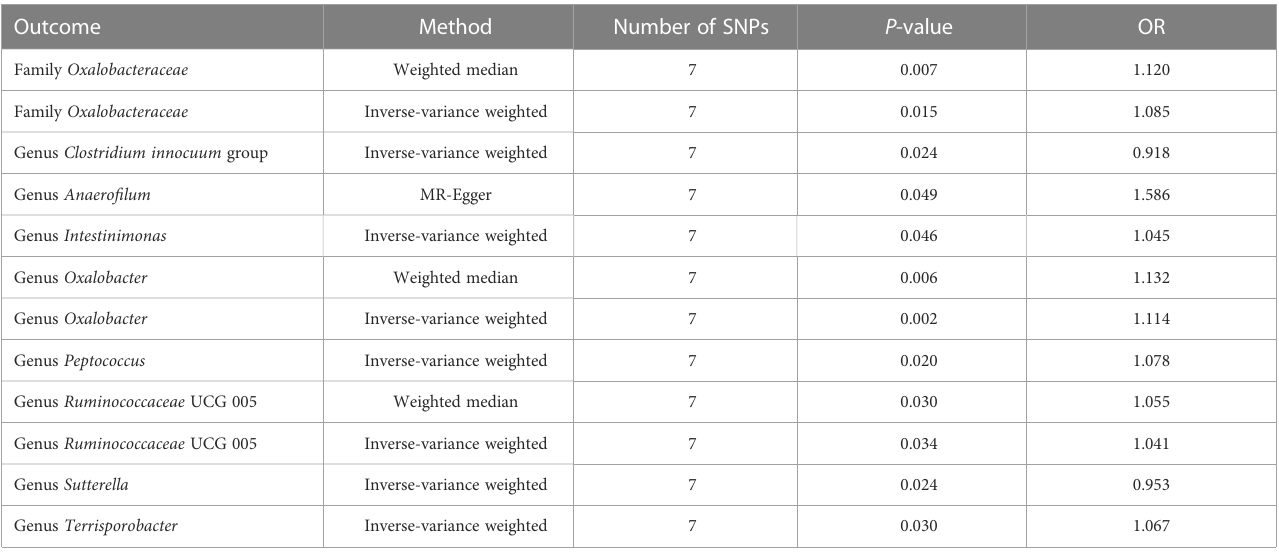
TABLE 3 Causal effect of Graves ’ disease (GD) on the gut microbiome.